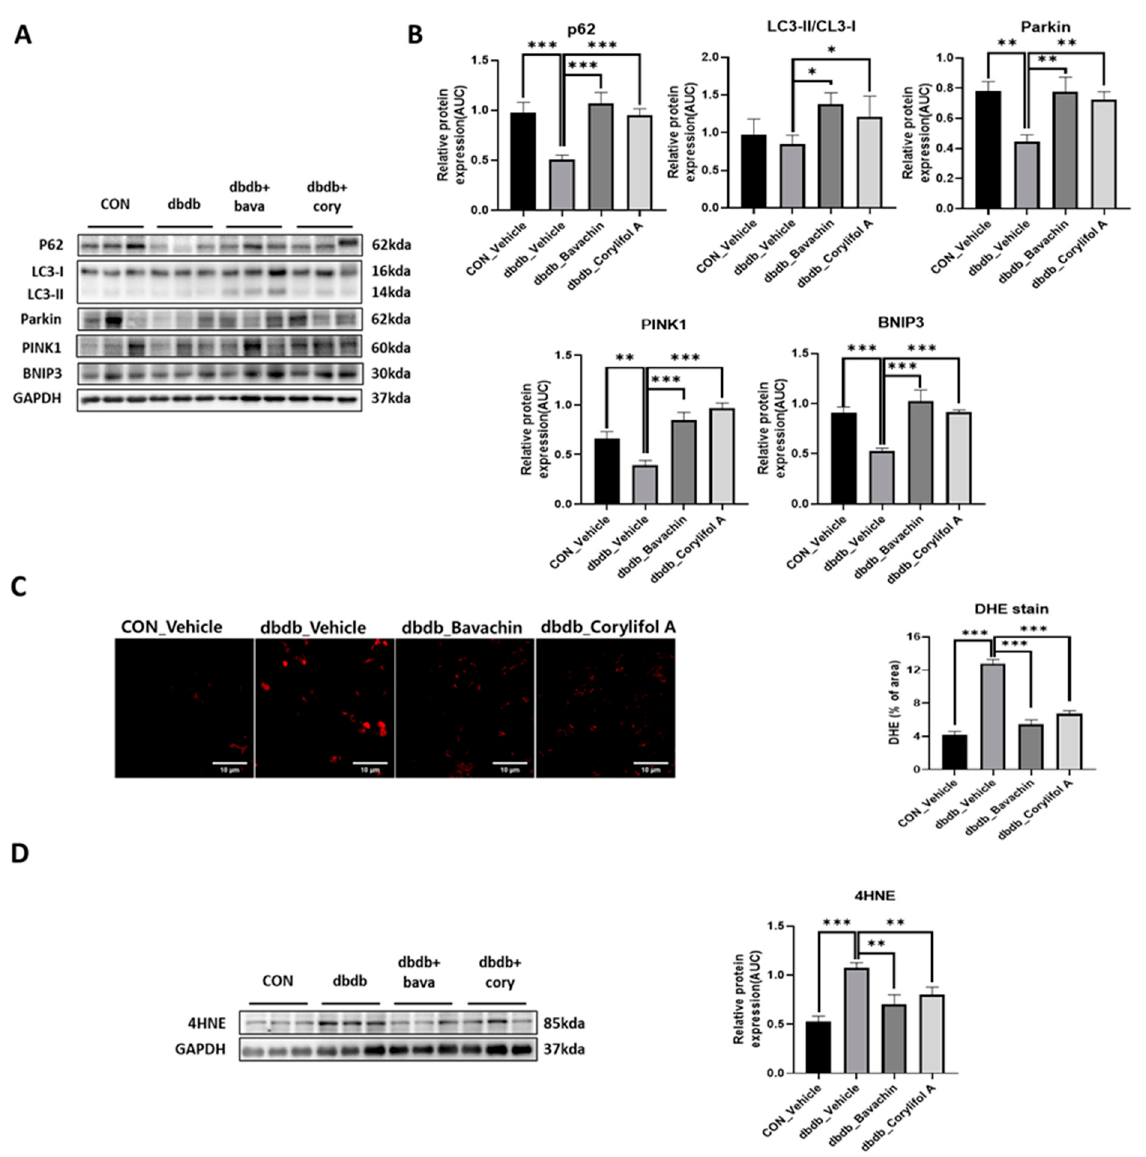
Figure 8. Bavachin and corylifol A promote mitophagy and improve the mitochondrial homeostasis. Twelve week old male db/db mice were administered bavachin (10 mg/kg) or corylifol A (10 mg/kg/day) for 40 d. Protein expression levels in the GA muscle were measured via western blotting. ( A ) Representative images of mitophagy factors. ( B ) Protein expression levels of mitophagy factors. ( C ) Dihydroethidium (DHE) staining. Images were captured at 600× magnification. ( D ) Protein expression levels of 4-hydroxynonenal (4HNE). All data are represented as the mean ± S.E.M., n = 6/group; * p < 0.05, ** p < 0.01, *** p < 0.001; nonparametric analysis of variance, followed by Kruskal-Wallis test.